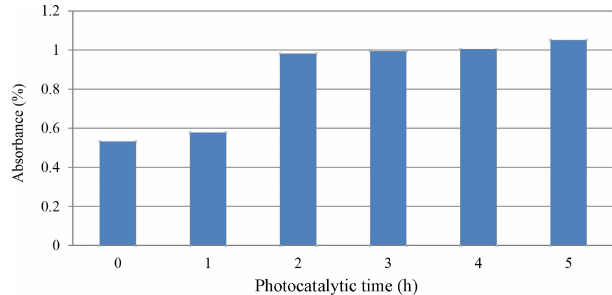
Figure 4. Photocatalytic degradation of methylene blue dye over Er 2 O 3 samples as a function of irradiation time with